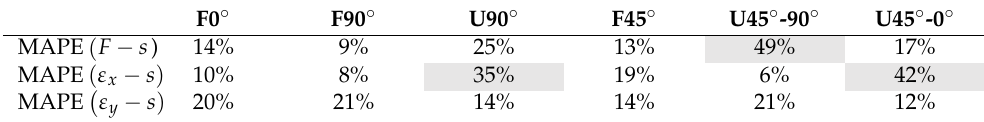
Table 2. Mean absolute percentage error (MAPE) for each fitting, rounded to full percent (larger values than 30% are highlighted in grey).